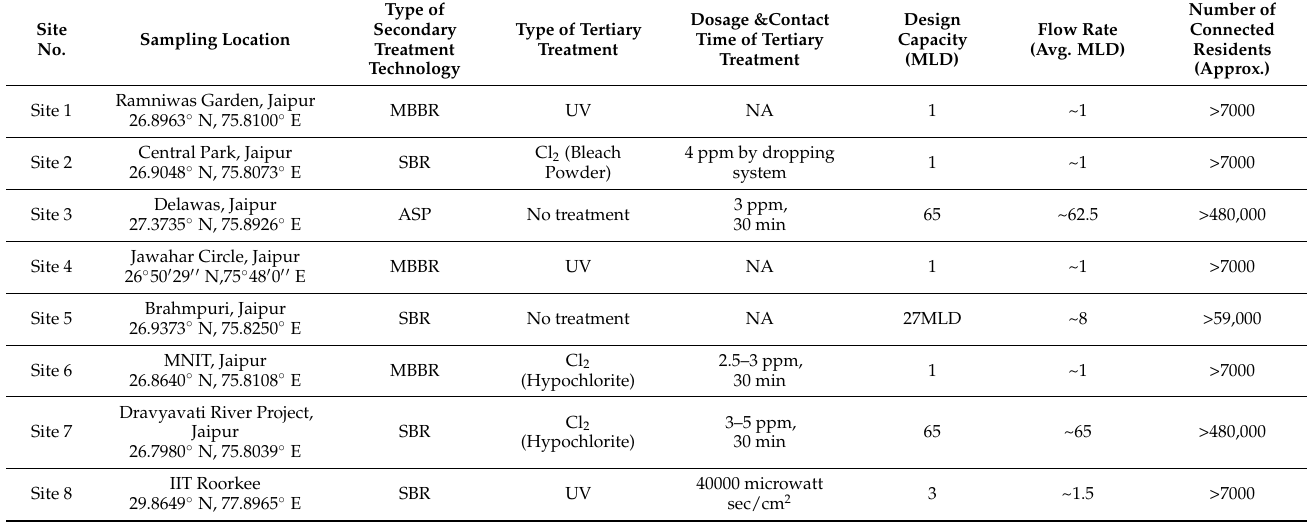
Table 2. Details on the sampling location sites along with treatment characteristics of WWTPs located in Rajasthan and Uttarakhand